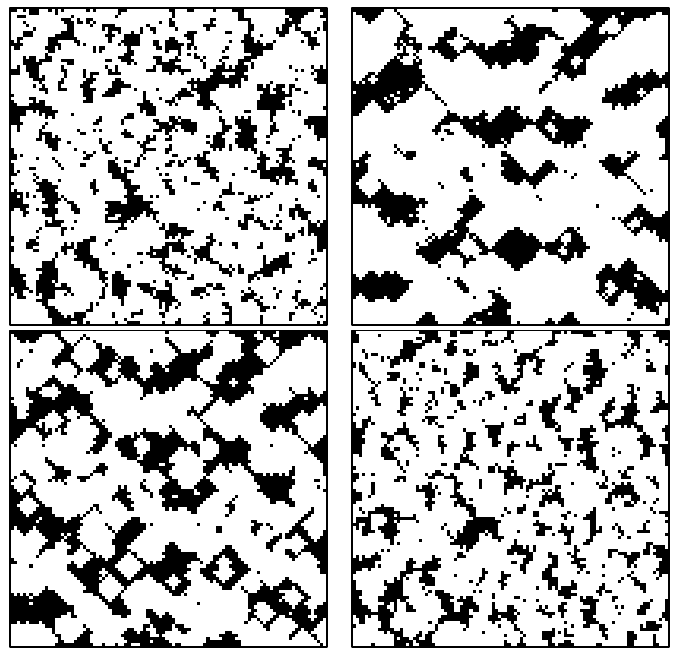
Figure 3. Several binary microstructures were made by changing the input parameters to test the efficiency of our realization code in generating morphologically diverse microstructures. Each 2D cut-section image above belongs to a distinct 3D microstructure, all having the same VF.